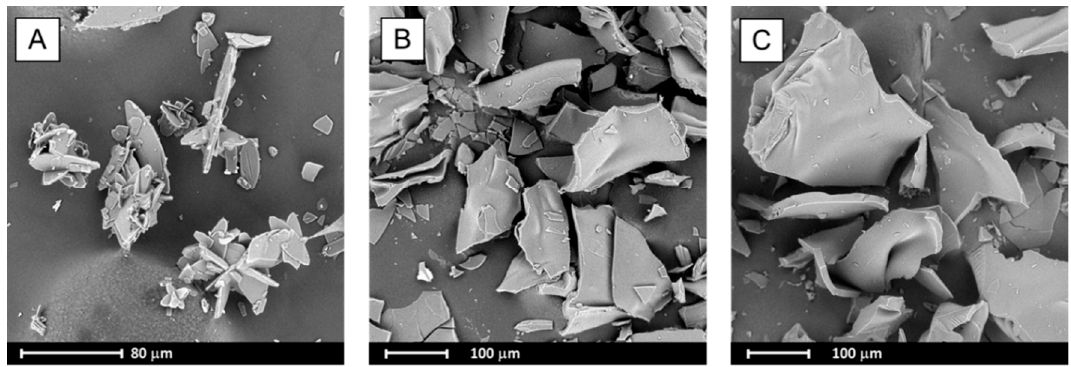
Figure 5. SEM images of evaporated systems: BCL ( A ), BCL–PVP 2:1 ( B ) and BCL–PVP 1:1 ( C ).